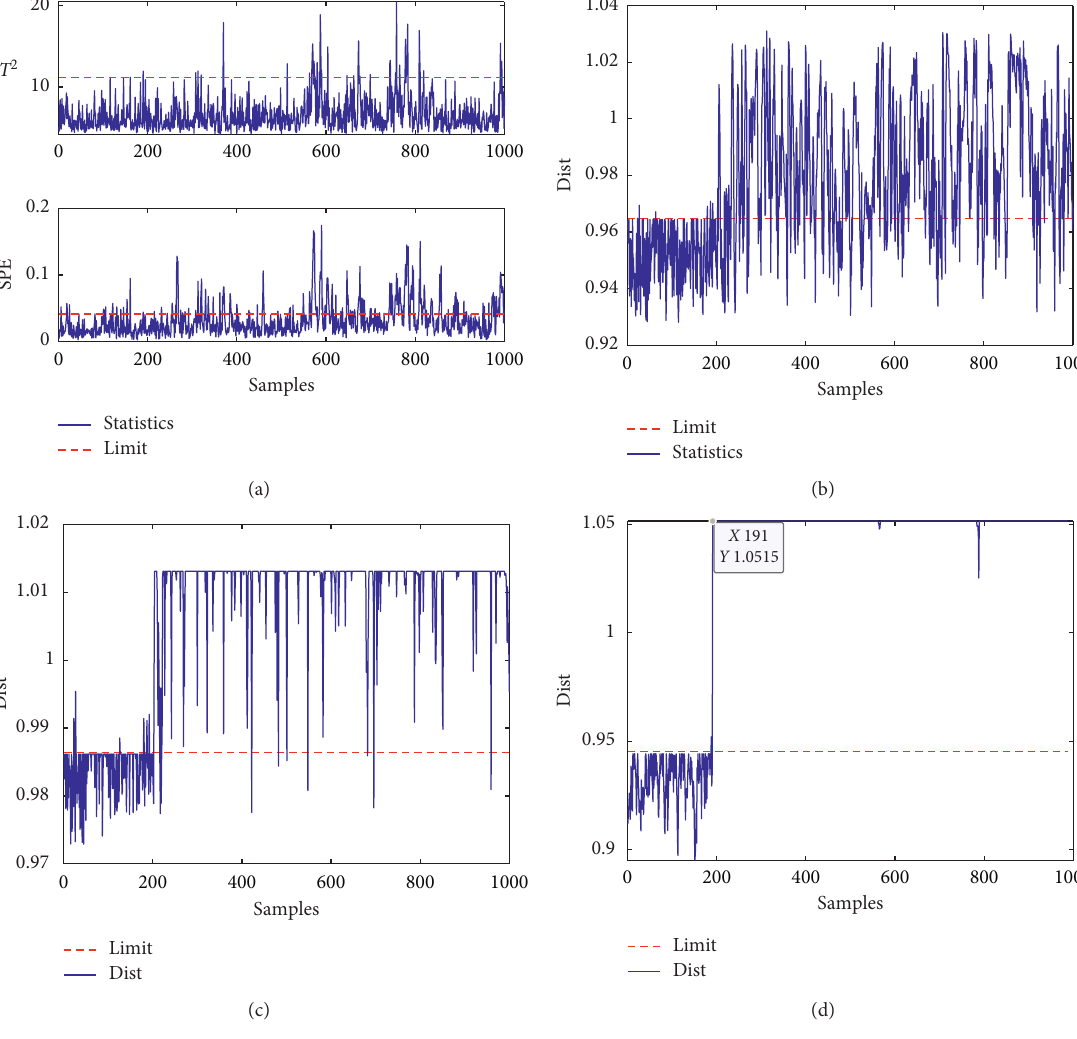
Figure 4: Monitoring results for fault 11 of Mode 3 by (a) KPCA, (b) conventional SVDD, (c) LDR-wSVDD, and (d)